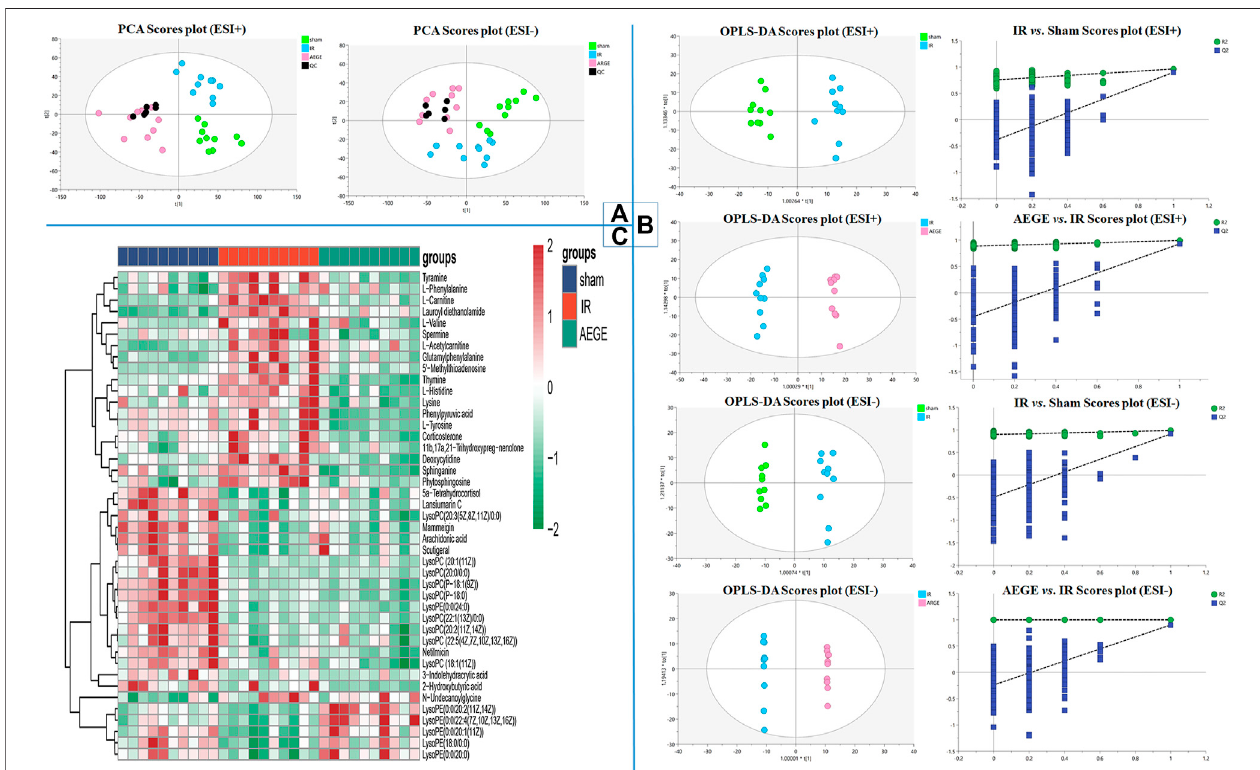
FIGURE 2 | Signatures of plasma metabolism in rats. (A) PCA score plot for the validation of quality control (QC). (B) OPLS-DA and permutation score plots of sham, IR, and AEGE groups. (C) Heatmap of metabolites in the cerebral ischemic injury of rats in the sham, IR, and AEGE groups. Red for higher level and blue for lower